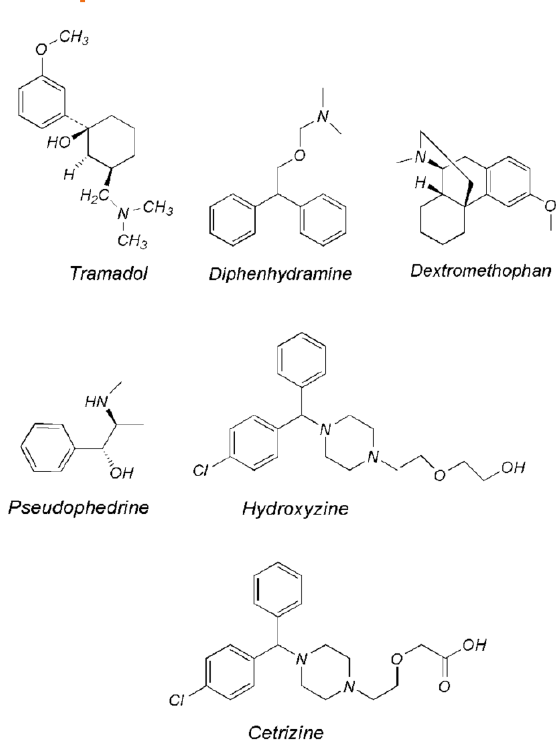
Figure 1. Chemical structures of investigated